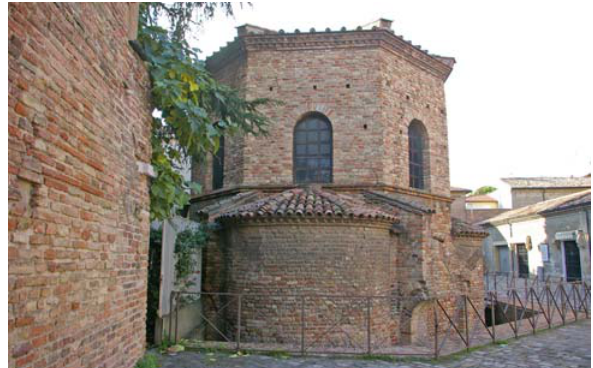
Figure 1. During 3D modelling of the Battistero degli Ariani using the SfM approach, the different height of the monument and of the square and the presence of a banister caused difficulties in the alignment of